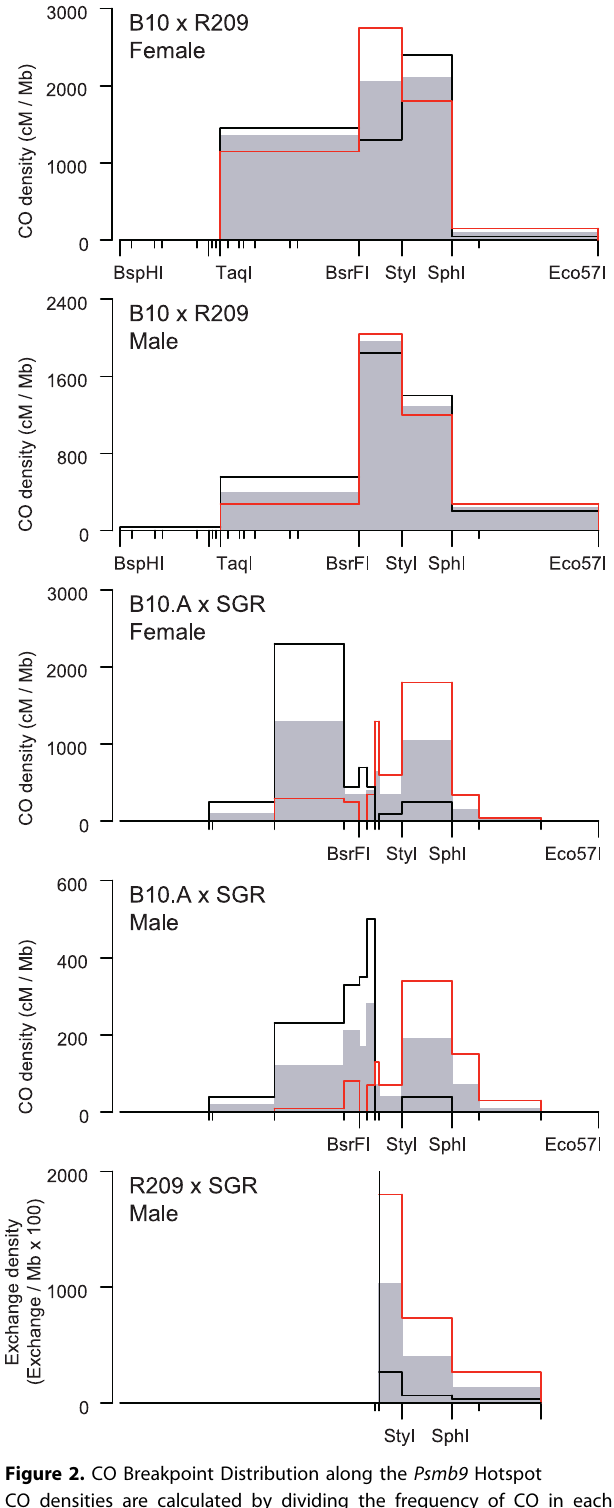
Figure 2. CO Breakpoint Distribution along the Psmb9 Hotspot CO densities are calculated by dividing the frequency of CO in each interval by its length. CO1 and CO2 represent exchanges in both orientations: black line, CO1 (orientation B10-R209, B10.A-SGR, and R209- SGR, respectively); red line, CO2 (orientation R209-B10, SGR-B10.A, and SGR-R209, respectively); gray area, orientation-averaged CO. Number of events: B10 3 R209, female, 112 CO1 and 76 CO2, male, 108 CO1 and 58 CO2; B10.A 3 SGR, female, 45 CO1 and 69 CO2, male, 62 CO1 and 62 CO2; R209 3 SGR, male, 21 CO1 and 73